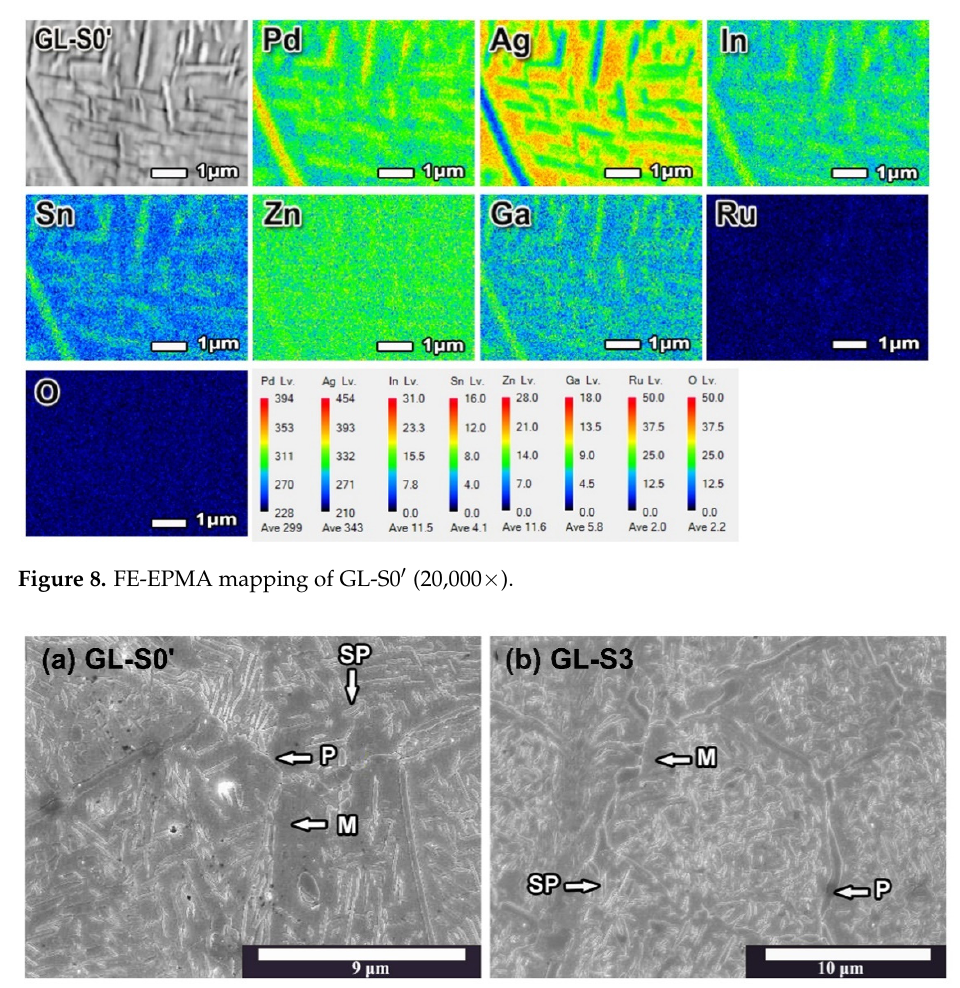
Figure 9. FE-SEM image of GL-S0 ′ ( a ) and GL-S3 ( b ) (M: matrix, P: precipitate in grain boundary, SP: precipitate in grain interior). Table 7. FE-EPMA spot analysis in the areas in Figure